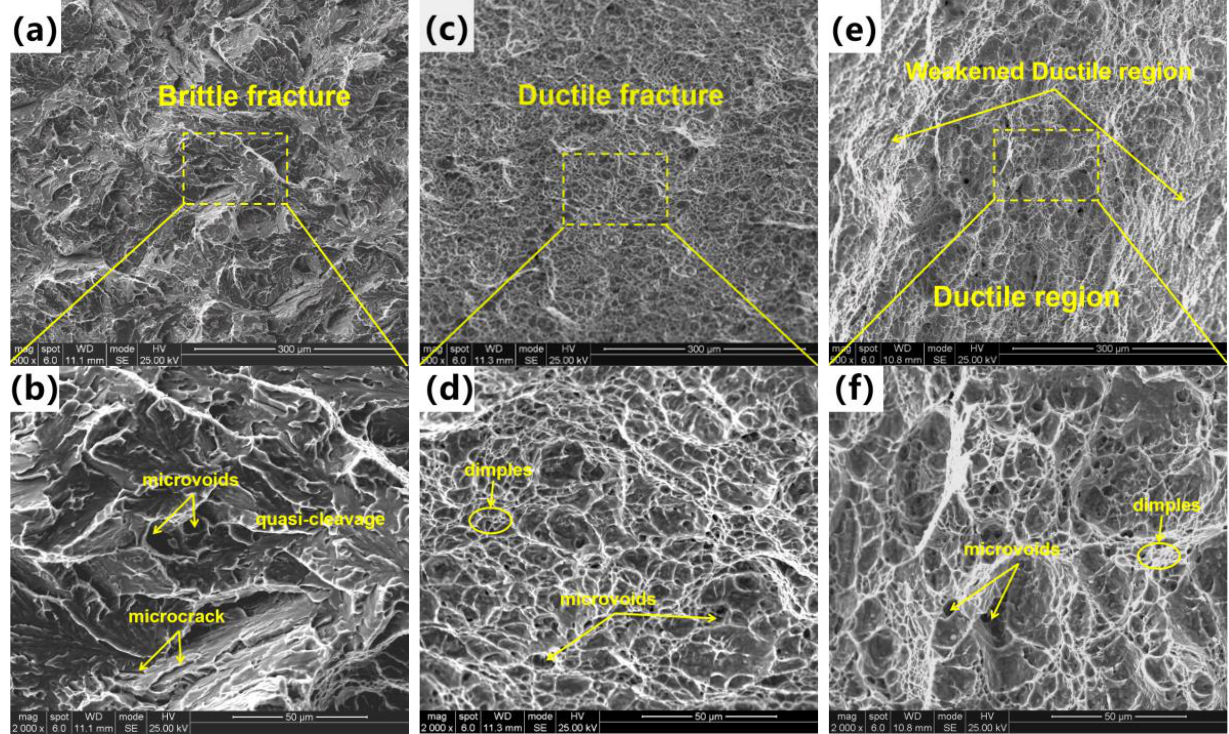
Figure 6. Impact fracture surfaces observed via SEM: ( a , b ) CR1, ( c , d ) CR2, ( e , f ) CR3.